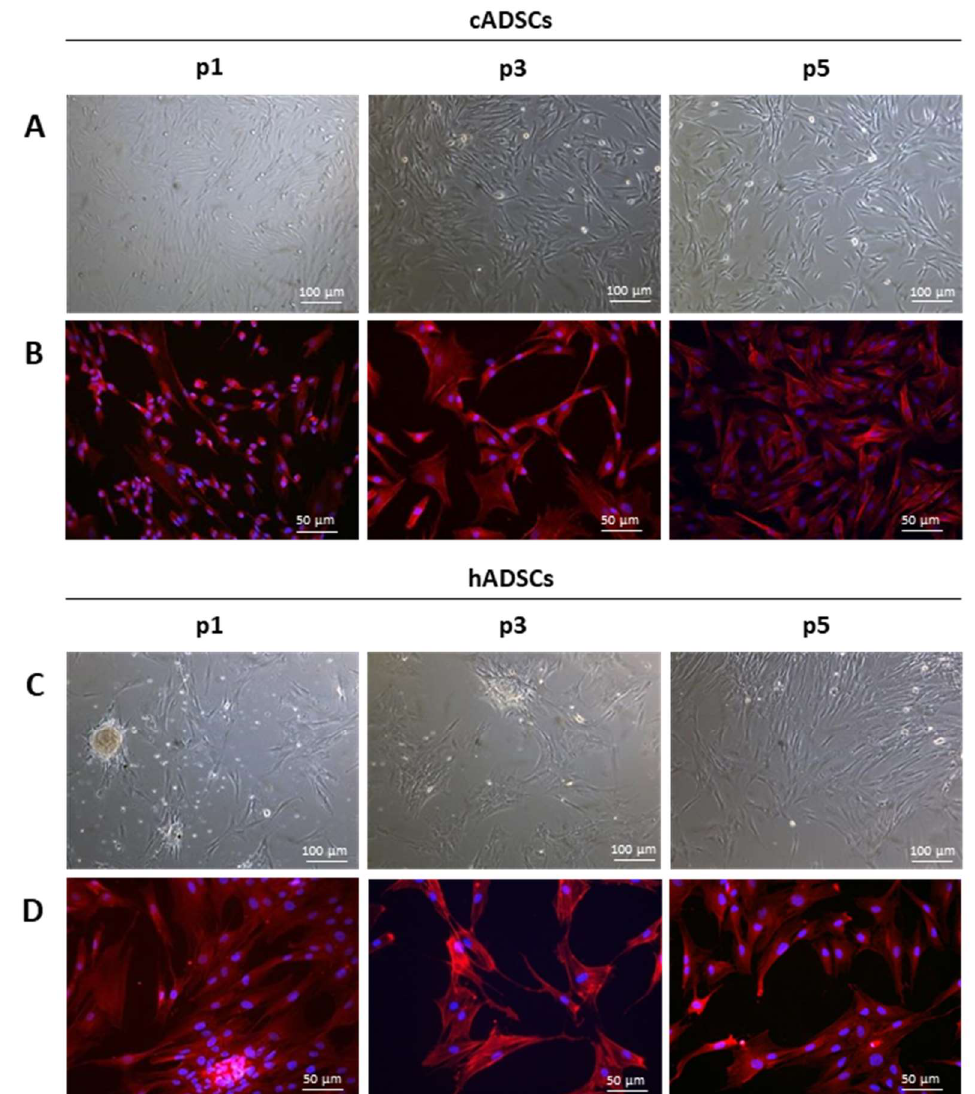
Figure 1. Morphology of canine adipose-derived stem cells (cADSCs) and human ADSCs (hADSCs). ( A , C ) Phase-contrast microscopy images (magnification 10×) showing the morphology of cADSCs and hADSCs, respectively, at passage 1 (p1), p3, and p5. ( B , D ) Actin cytoskeleton staining (magnification 20×) with phalloidin (in red) of cADSCs and hADSCs, respectively, at p1, p3, and p5. Nuclei are counterstained with Hoechst (in blue).